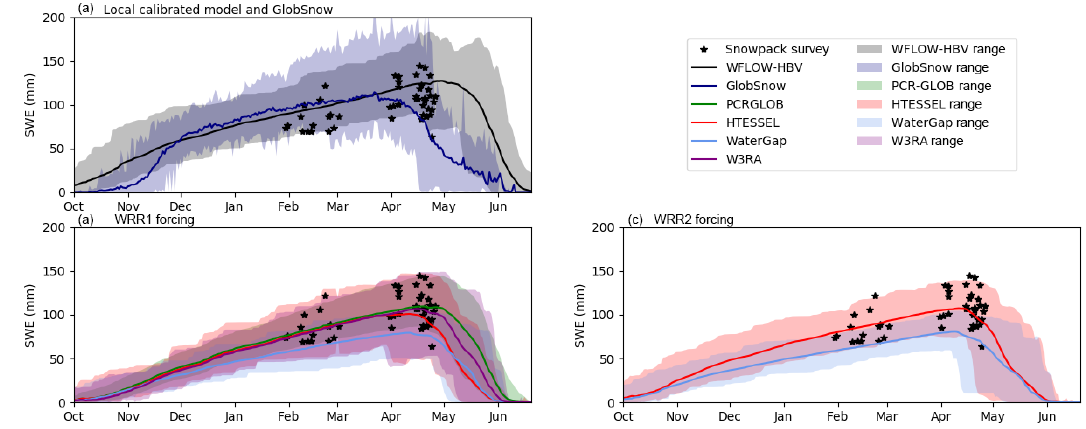
Figure 3. Daily mean, maximum and minimum daily SWE compared to ground measurements (1980–2012).